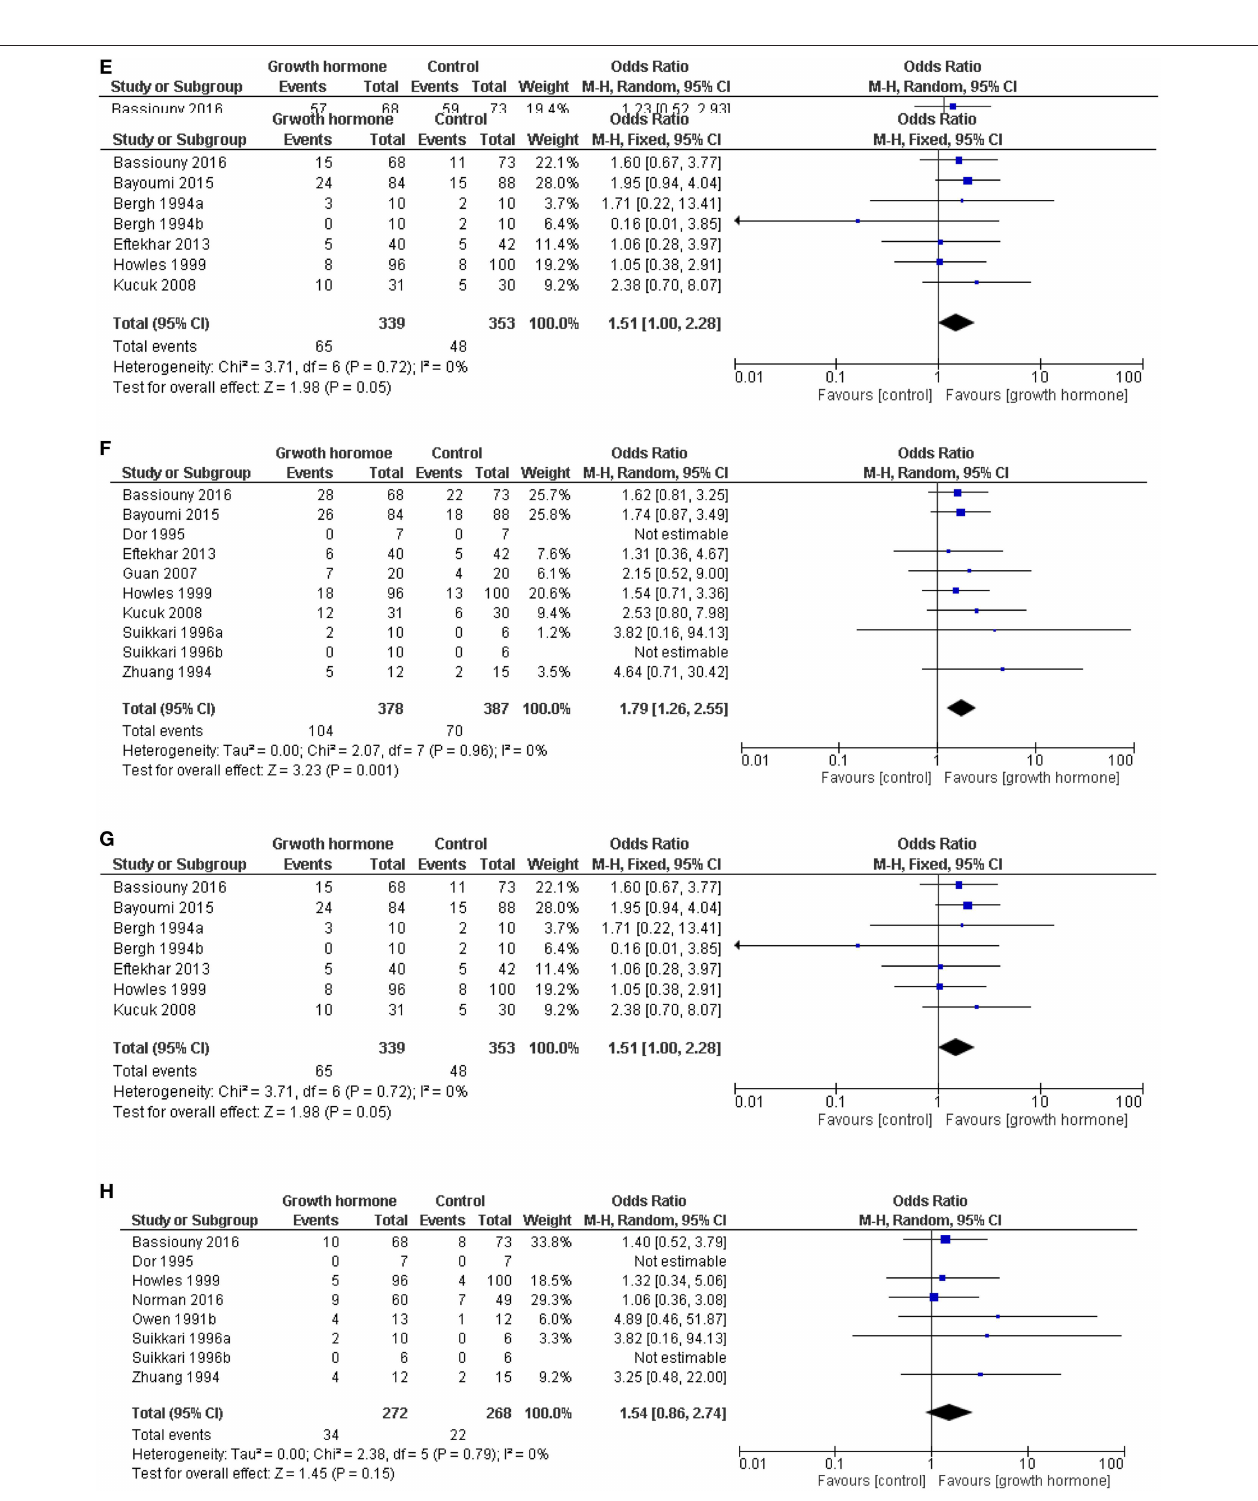
FIGURE 1 | Meta-analysis of the use of GH in poor responders. Forest plots of outcomes from the use of growth hormone in “poor responders” undergoing ovarian stimulation. Where possible data presented per cycle started (median and range converted to mean and std. dev.) Software RevMan Version 5.3. Copenhagen: The Nordic Cochrane Centre, The Cochrane Collaboration, 2014. Reproduced with permission from Hart et al. (15). (A) Forest plot of comparison: oocytes collected per cycle started. Not all patients reached oocyte retrieval. (B) Patients reached oocyte retrieval and had at least one oocyte retrieved. (C) The duration of stimulation. (D) Number of fertilized oocytes for women per cycle started (some data is presented by patients who had oocytes retrieved). (E) Patients with an embryo available for transfer per cycle started. (F) Positive pregnancy test per cycle started. (G) Clinical pregnancy per cycle started. (H) Live birth per cycle started (15, 31–41).